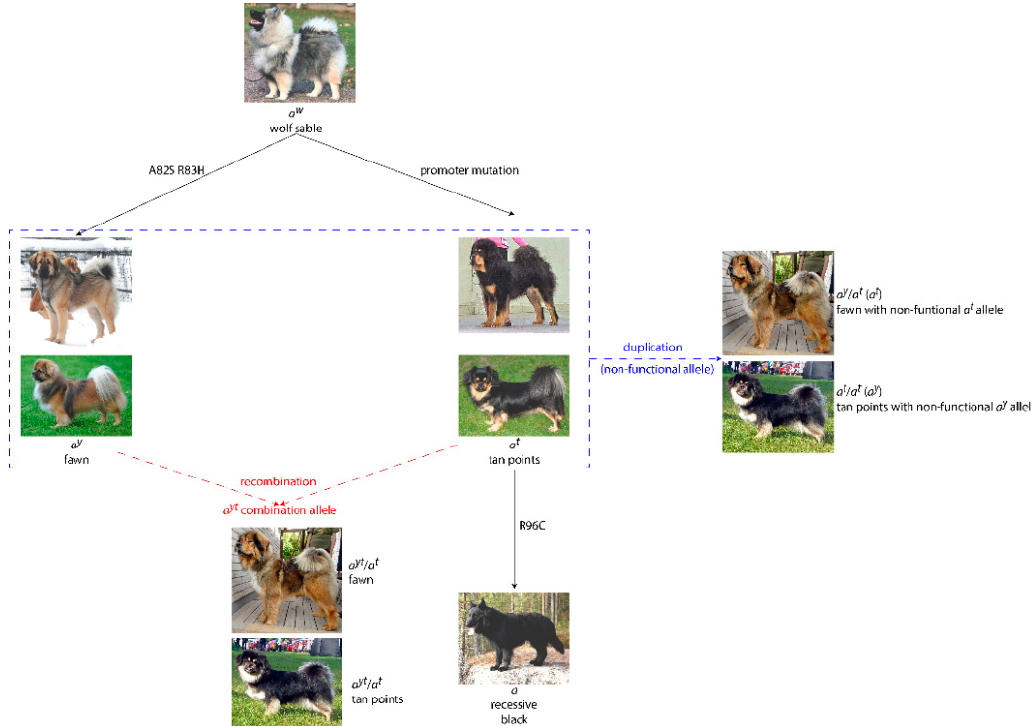
Figure 2. The evolution of ASIP alleles with alternate means by which A 3+ may have arisen. Blue dashed lines outline the possible duplication of the a y and a t alleles into non-functional copies. Red dashed lines indicate the recombination of the a y and a t alleles into a combined a yt allele. An example of a fawn colored Tibetan Mastiff and a tan-pointed Tibetan Spaniel, both having been genotyped as a y / a t / a t , are used to illustrate each mechanism.